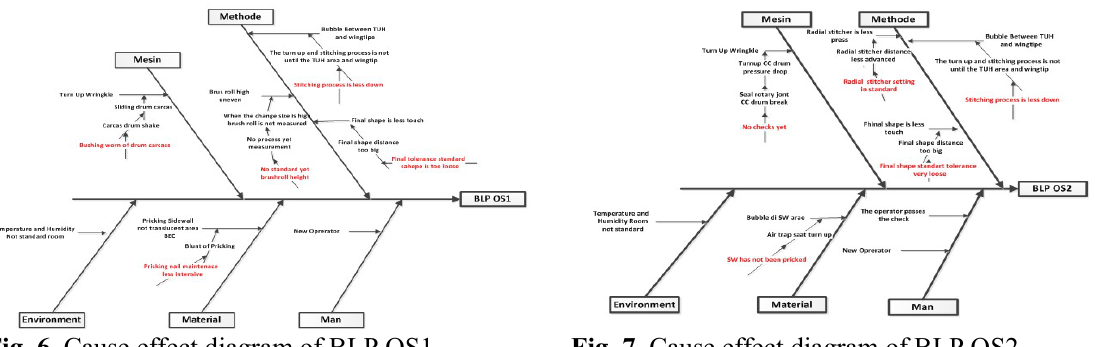
Fig. 6 . Cause effect diagram of BLP OS1 Fig. 7. Cause effect diagram of BLP